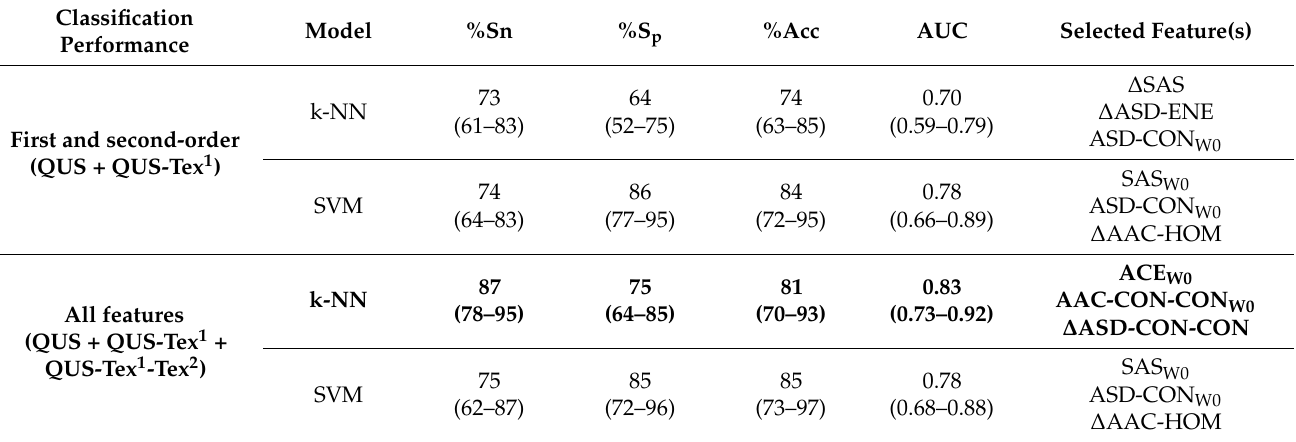
∆ Indicates the difference of values of week 4 from week 0 for each feature included in the analysis. The best classifier performances using the k-NN model have been highlighted in bold. The values